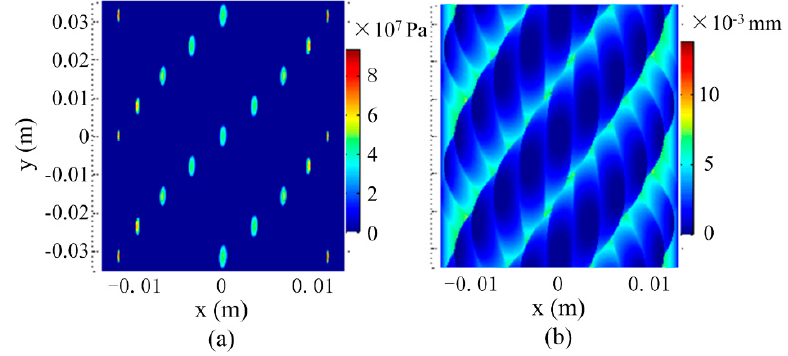
Figure 2. ( a ) Pressure on the friction lining surface; ( b ) the gap height for load w = 1960 N.